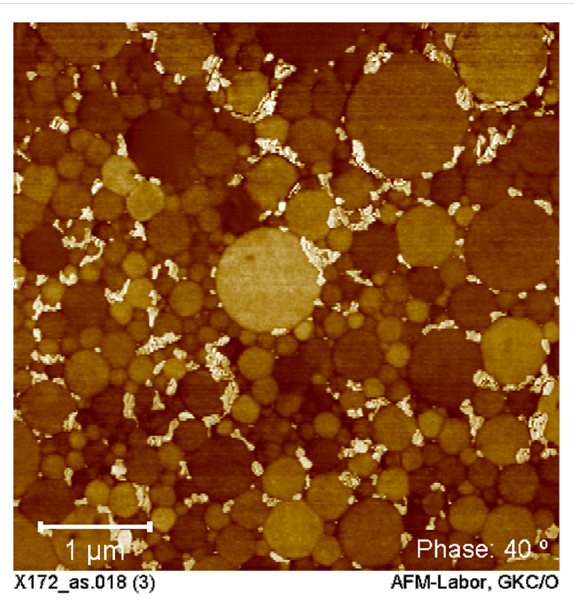
Figure 3: AFM image produced from COE/DCPD latex film. Measure- ment: AFM tapping at room temperature, material contrast using Phase